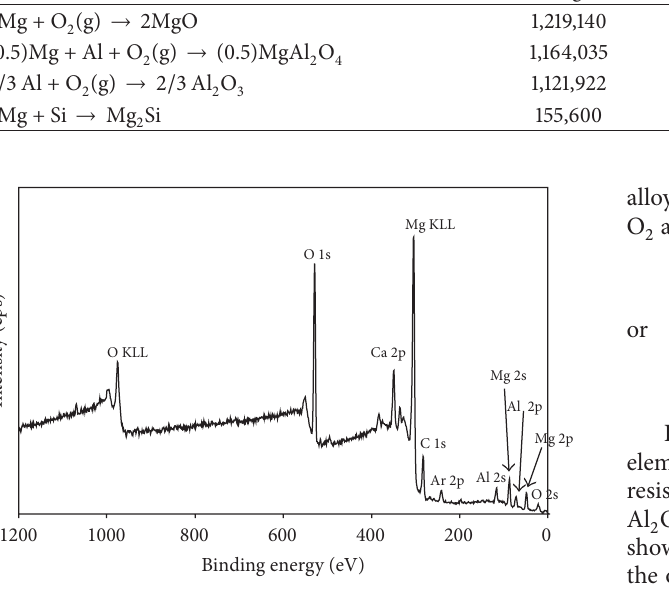
Table 3: The possible chemical reaction and standard Gibbs free energies during oxidation at 600 ∘ C. Reaction